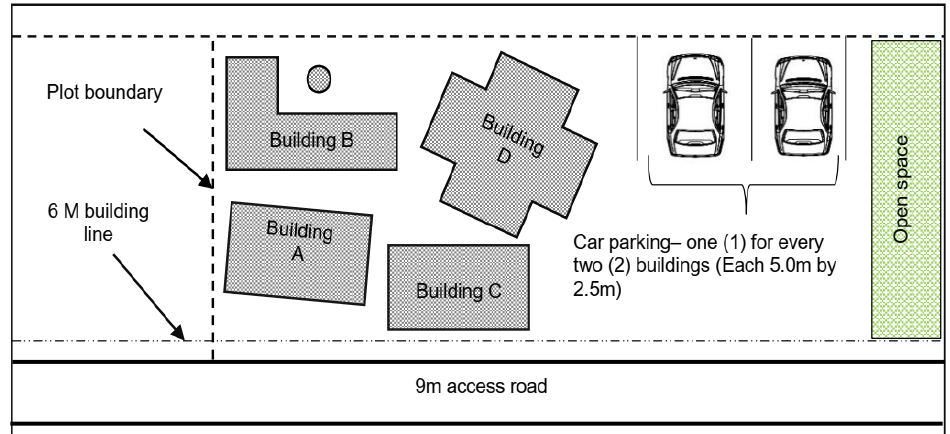
Fig. 2: An illustration of the ratio of residential buildings to car parking space